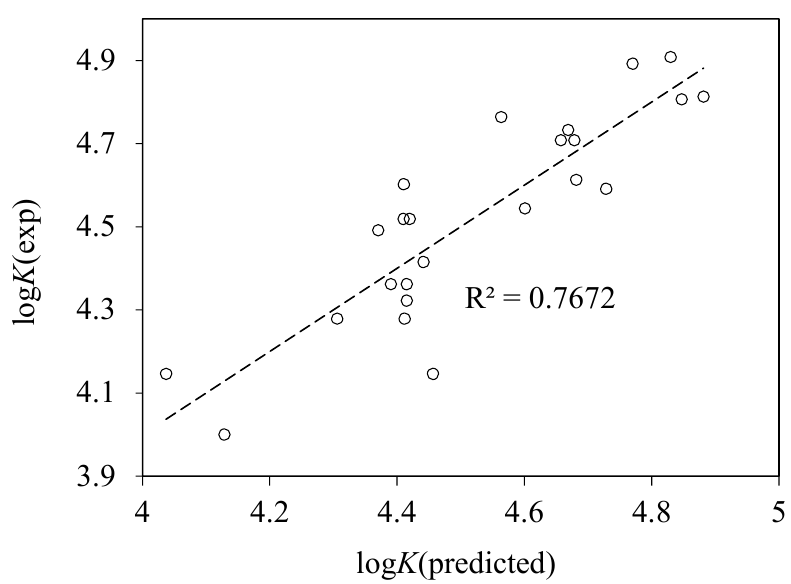
Figure 8. Plot of the experimental vs. predicted logarithms of binding constants log K obtained using the best two-parameter model (Equation (10)) with parameters from eDragon descriptor set.